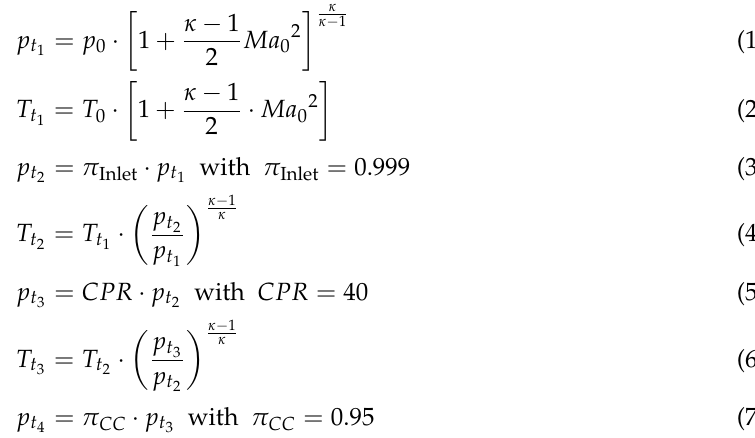
Figure 6. Schematic combustion chamber with inlet and outlet conditions